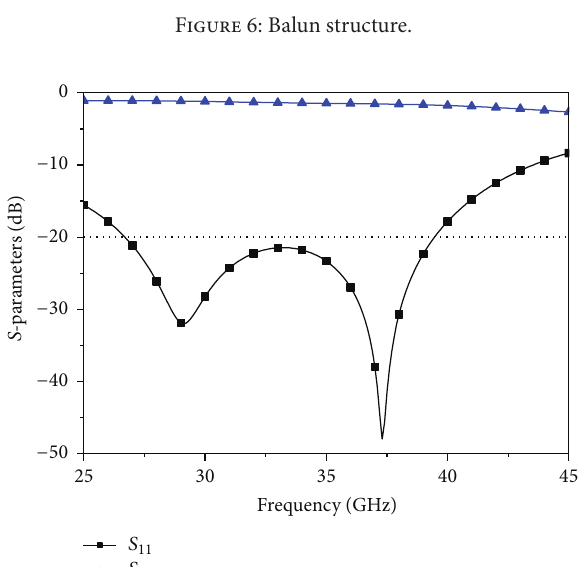
Figure 6: Balun structure.